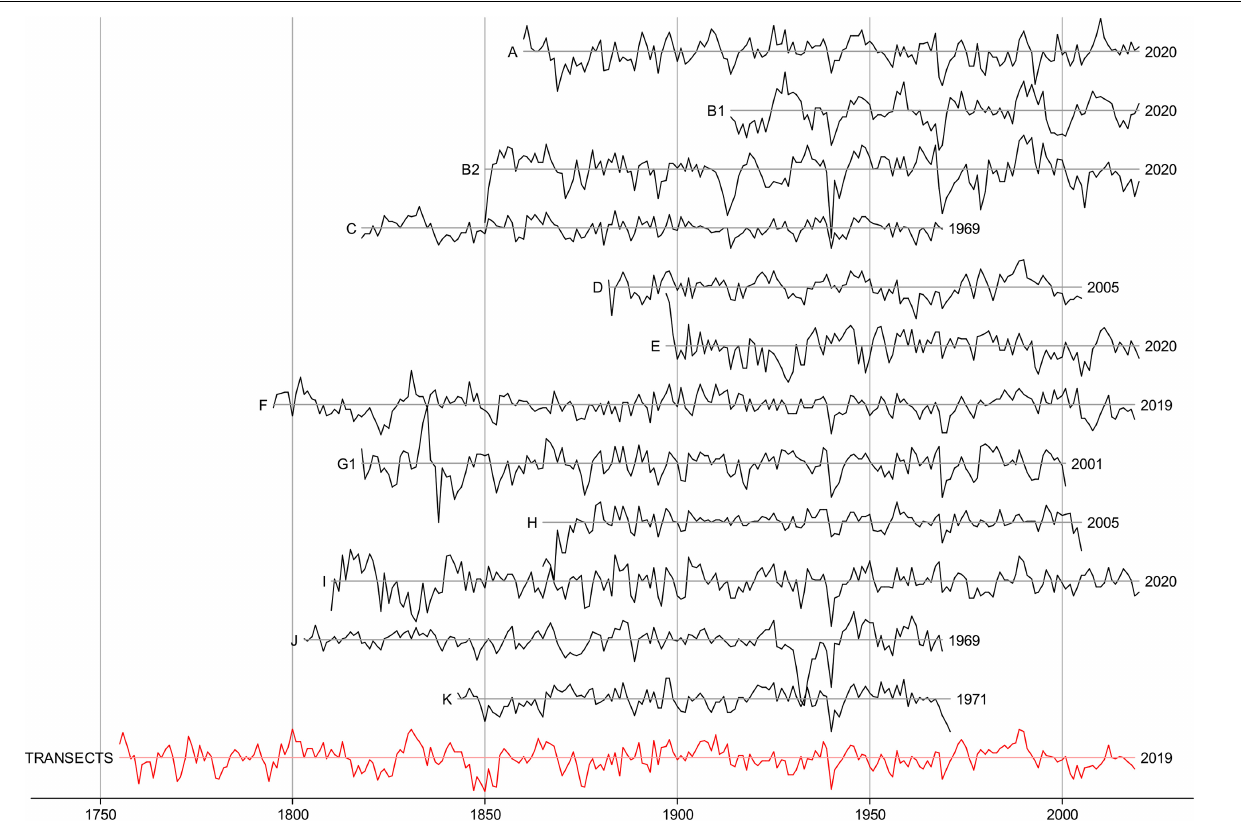
FIGURE 4 | Graph of chronology (red line) compiled from TRW series data of pines selected along the five transects and graphs of the absolute reference chronologies (A–K) in synchronous arrangement.